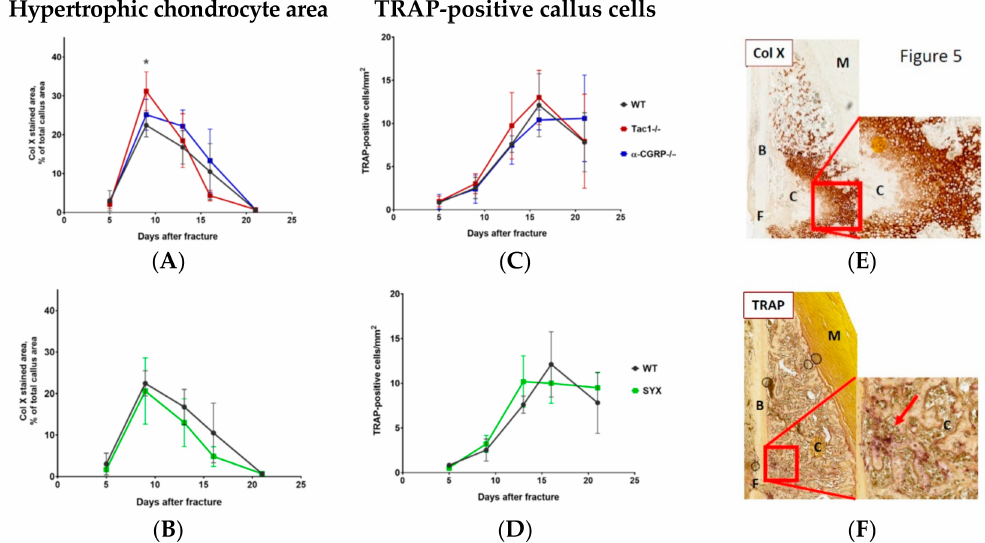
Figure 5. Hypertrophic cartilage area and number of TRAP-positive callus cells . ( A , B ) Number / area of hypertrophic chondrocytes, visualized by collagen X staining, in Tac1 − / − , α -CGRP − / − ( A ), SYX ( B ), and WT mice ( A , B ) at the time points 5, 9, 13, 16, and 21 days after fracture. Values were calculated as a percentage of total callus area and are presented as mean ± SD. * in black indicates di ff erences between neurotransmitter deficient mice and WT animals. ( C , D ) Number of TRAP-positive cells in the callus tissue of Tac1 − / − , α -CGRP − / − ( C ), SYX ( D ), and WT mice ( C , D ) at the time points 5, 9, 13, 16, and 21 days after fracture. The number of cells was calculated in relation to the total area of callus tissue as number / mm 2 . ( E ) Representative image of collagen X stained hypertrophic callus area of an α -CGRP − / − mouse 13 days after fracture. ( F ) Representative image of TRAP-positive callus cells 16 days after fracture in the callus tissue of a WT mouse. Overview images scanned with 20 × magnification (TissueFAXSi plus). Red boxes demonstrate the enlarged view. Red arrow points to stained cells. Col X = collagen X; B = bone, C = Callus tissue, F = Fracture site, M = Muscle. * = p ≤ 0.05. N =